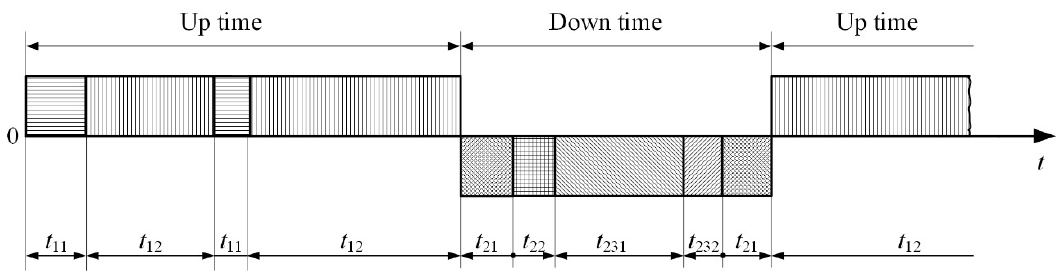
Figure 1. Time state picture. t 1, uptime; t 11 , standby time; t 12 , time in operation; t 2 , downtime; t 21 , organizational time; t 22 , logistic time; t 23 , repair time ( t 231 , corrective; t 232 , preventive repair).